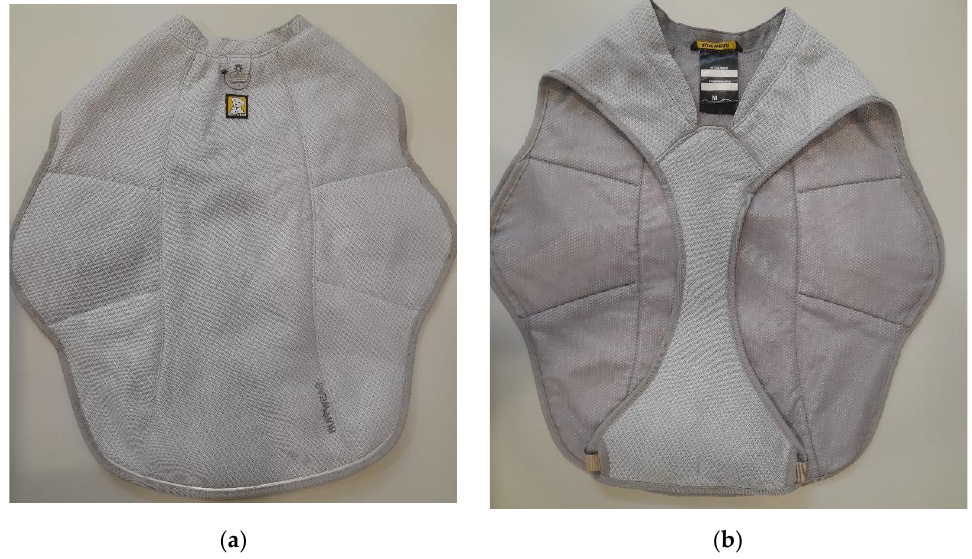
Figure 4. Detail of the outside ( a ) and inside ( b ) of the evaporative cooling vest Swamp Cooler TM used in this clinical study. It consists of three layers to absorb water and facilitate evaporation. Requires wetting with clean water before use.